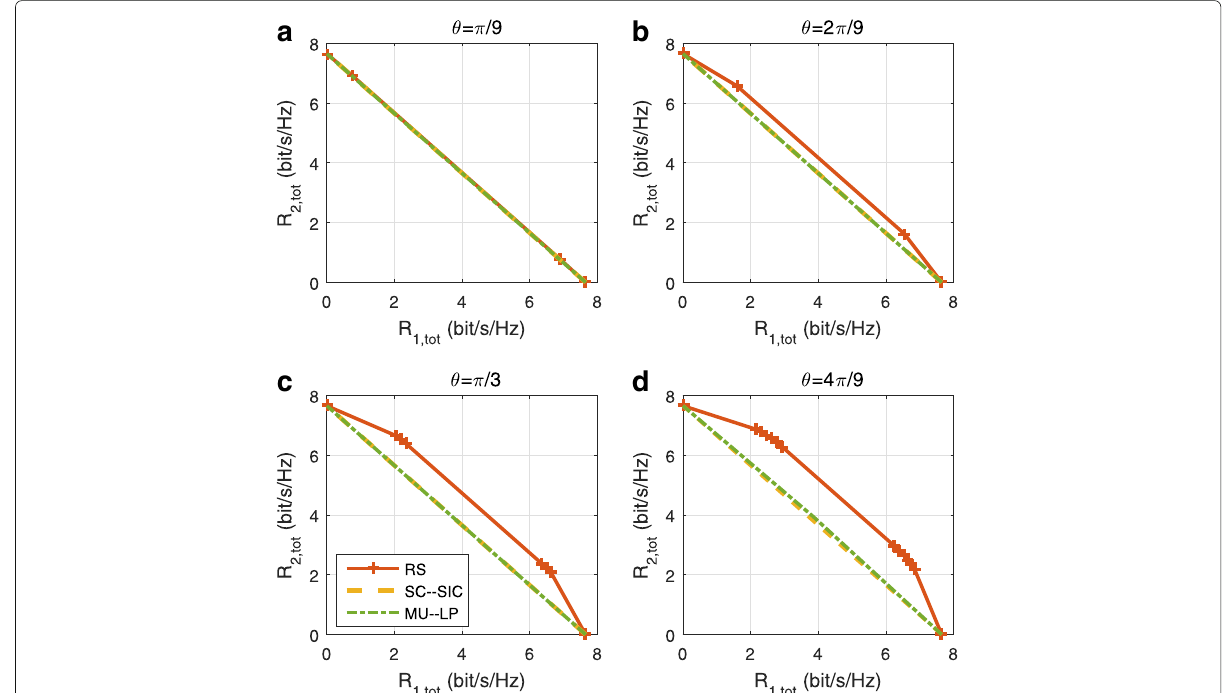
Fig. 29 Average rate region comparison of different strategies in imperfect CSIT, γ = 1, N t = 2, SNR = 20 dB. a θ = π/ 9. b θ = 2 π/ 9. c θ = π/ 3. d θ = 4 π/ 9